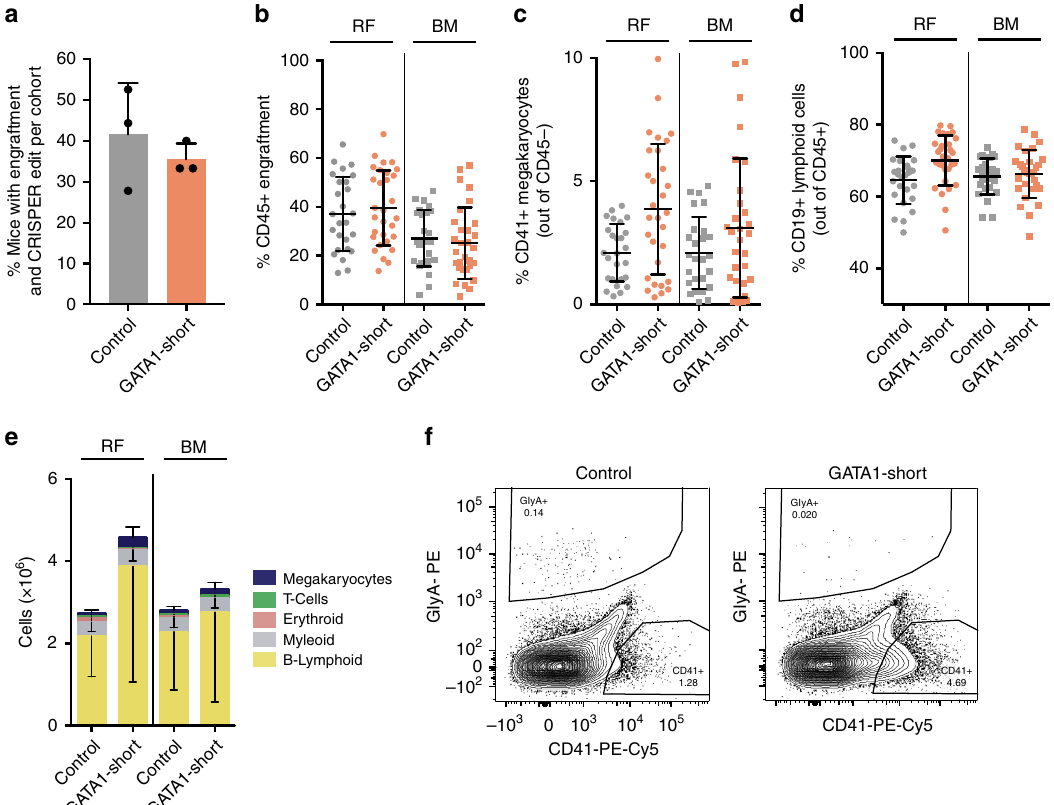
Fig. 3 Functional interrogation of single CRISPR/Cas9-edited hematopoietic stem cells in NSG mice. a Percentage of CRISPR/Cas9 edited LT-HSCs injected NSG mice with engraftment (>5% based on human CD45 + expression in RF) and high CRISPR/Cas9 knockout ef fi ciency (>90% based on PCR and Sanger sequencing) from each of three cohorts ( n = 3 animal cohorts with independent cord blood pools). b Engraftment levels of control and GATA1-short edited LT-HSCs injected NSG mice based on human CD45 + expression in RF and BM. c Percentage of CD41 + CD45 − megakaryocytes of control and GATA1- Short edited LT-HSCs injected NSG mice in RF and BM (unpaired t test P < 0.005 for RF GATA1-Short versus RF control and unpaired t test P = 0.107 for BM GATA1-Short versus BM control). d Percentage of CD19 + CD45 + lymphoid cells in control and GATA1-Short edited LT-HSCs injected NSG mice in RF and BM (unpaired t test P < 0.005 for RF GATA1-Short versus RF control). e Absolute cell numbers of different lineages in control and GATA1-Short edited LT-HSCs injected NSG mice in RF and BM (unpaired t test P < 0.01 for B-lymphoid RF GATA1-Short versus RF control and unpaired t test P < 0.005 for megakaryocytes RF GATA1-Short versus RF control). f Representative fl ow cytometry plots of control and GATA1-Short edited LT-HSCs injected NSG